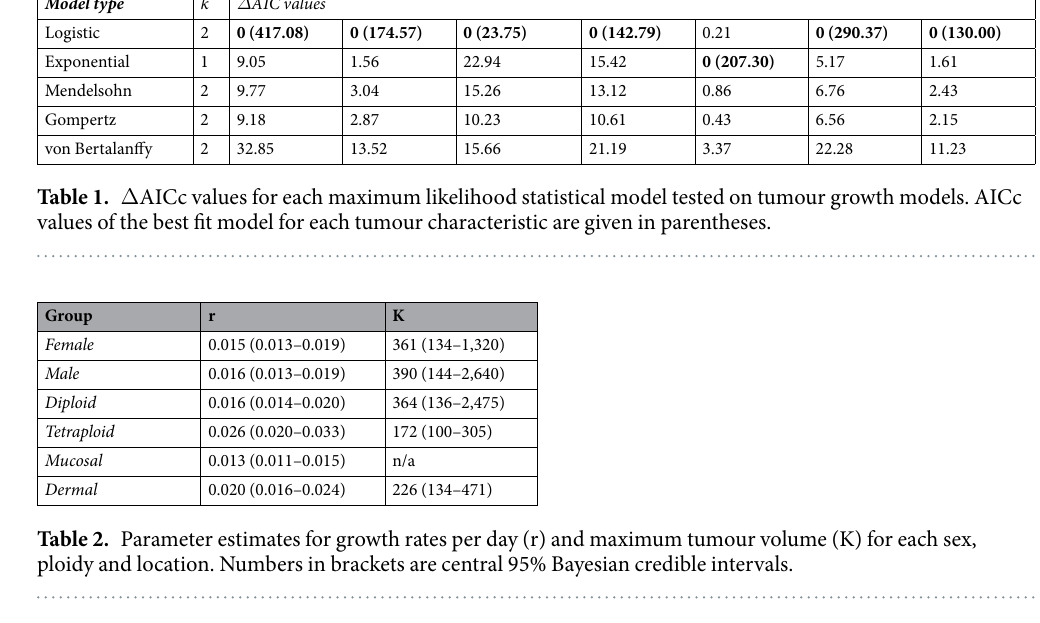
All data Diploid Tetraploid Mucosal Dermal